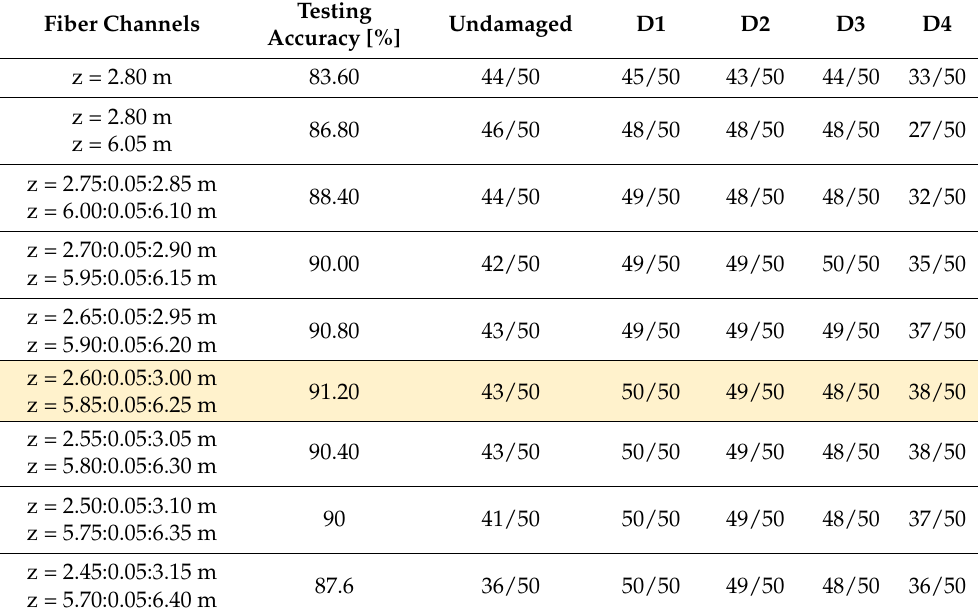
Table 1. Testing accuracy of the SVM classifiers used for damage detection and localization, for various combinations of fiber